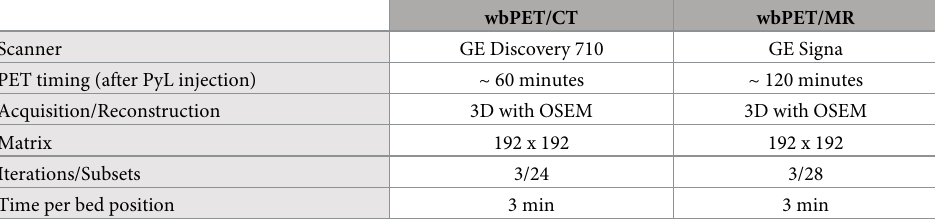
Table 1. PET acquisition